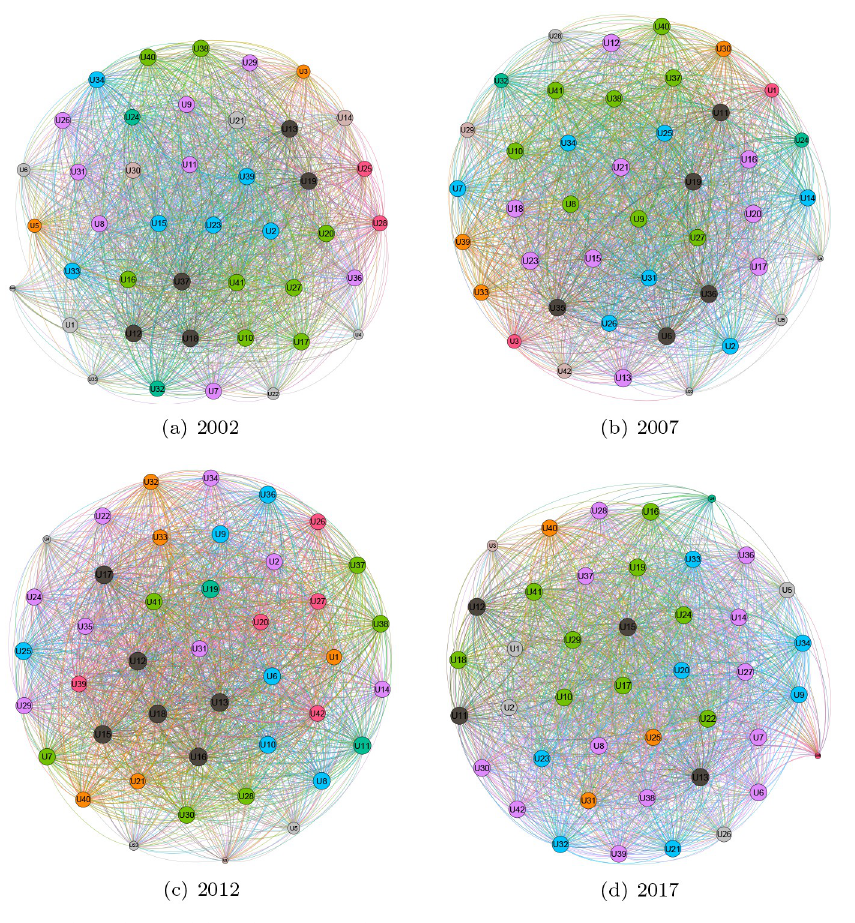
Fig 3. The evolution of the industry network.